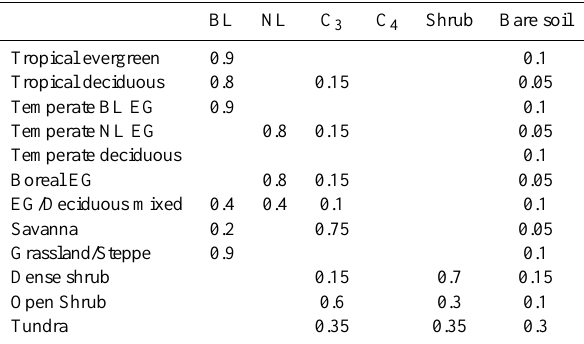
Table 3. Mapping from SAGE vegetation classes to JULES PFTs.